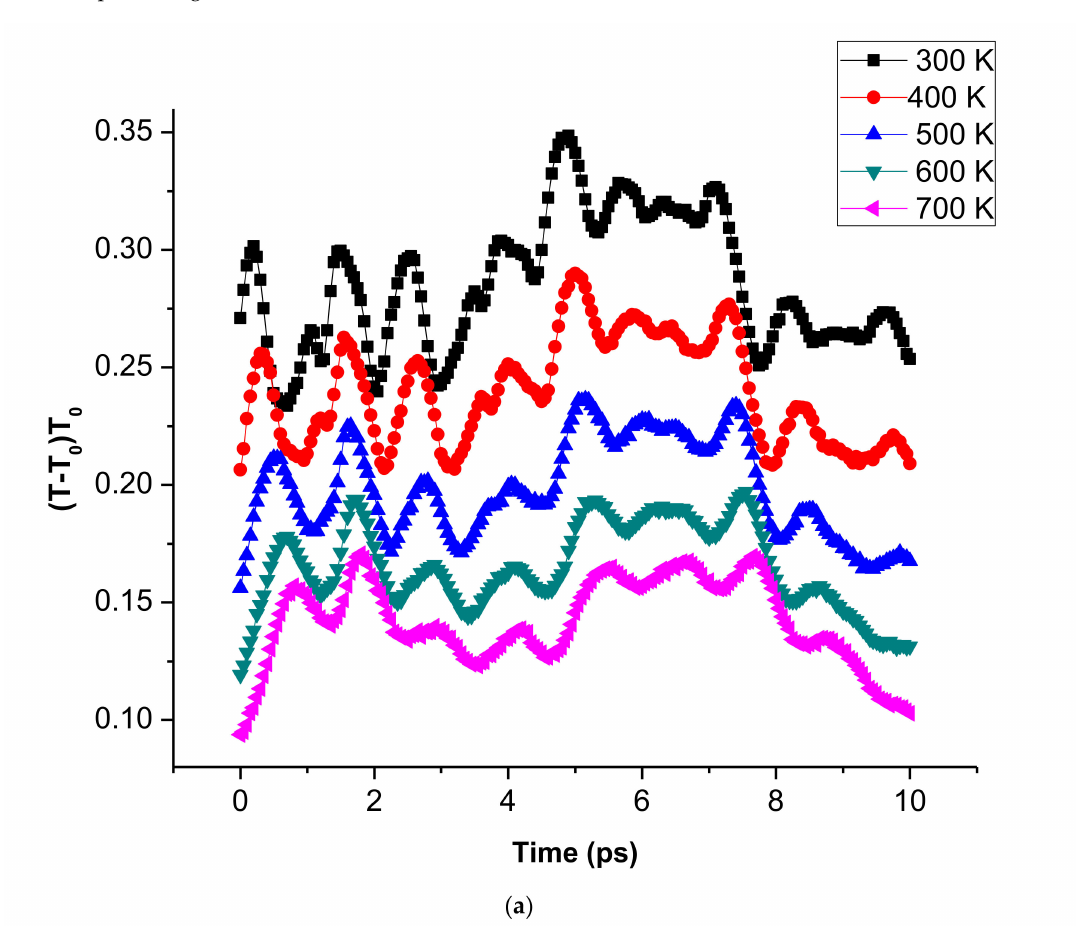
Figure 2. Cross-section configurations of vanadium thin film at ( a ) 300 K, ( b ) 500 K and ( c ) 700 K at 0.5 Å / ps loading